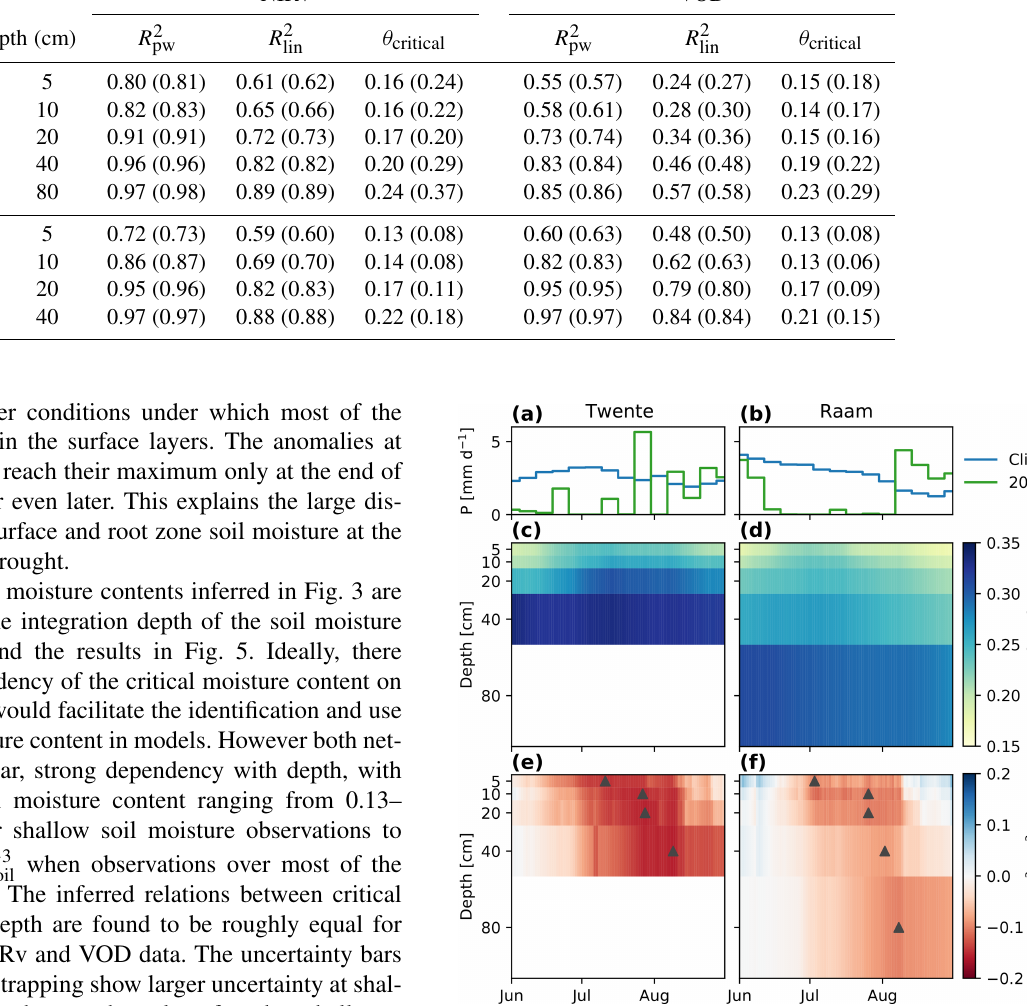
Figure 4. Temporal evolution of observed precipitation and soil moisture profiles during the 2018 drought. For precipitation, (a, b) show the precipitation recorded at the KNMI stations of Twenthe and Volkel (see location in Fig. 1c and d). For soil moisture, the climatology (mean 2016–2017, panels c and d ) and the 2018 anomalies (e, f) are shown for Twente (a, c, e) and Raam (b, d, f) . The triangles in (e) and (f) indicate the moment of maximum negative anomaly at each